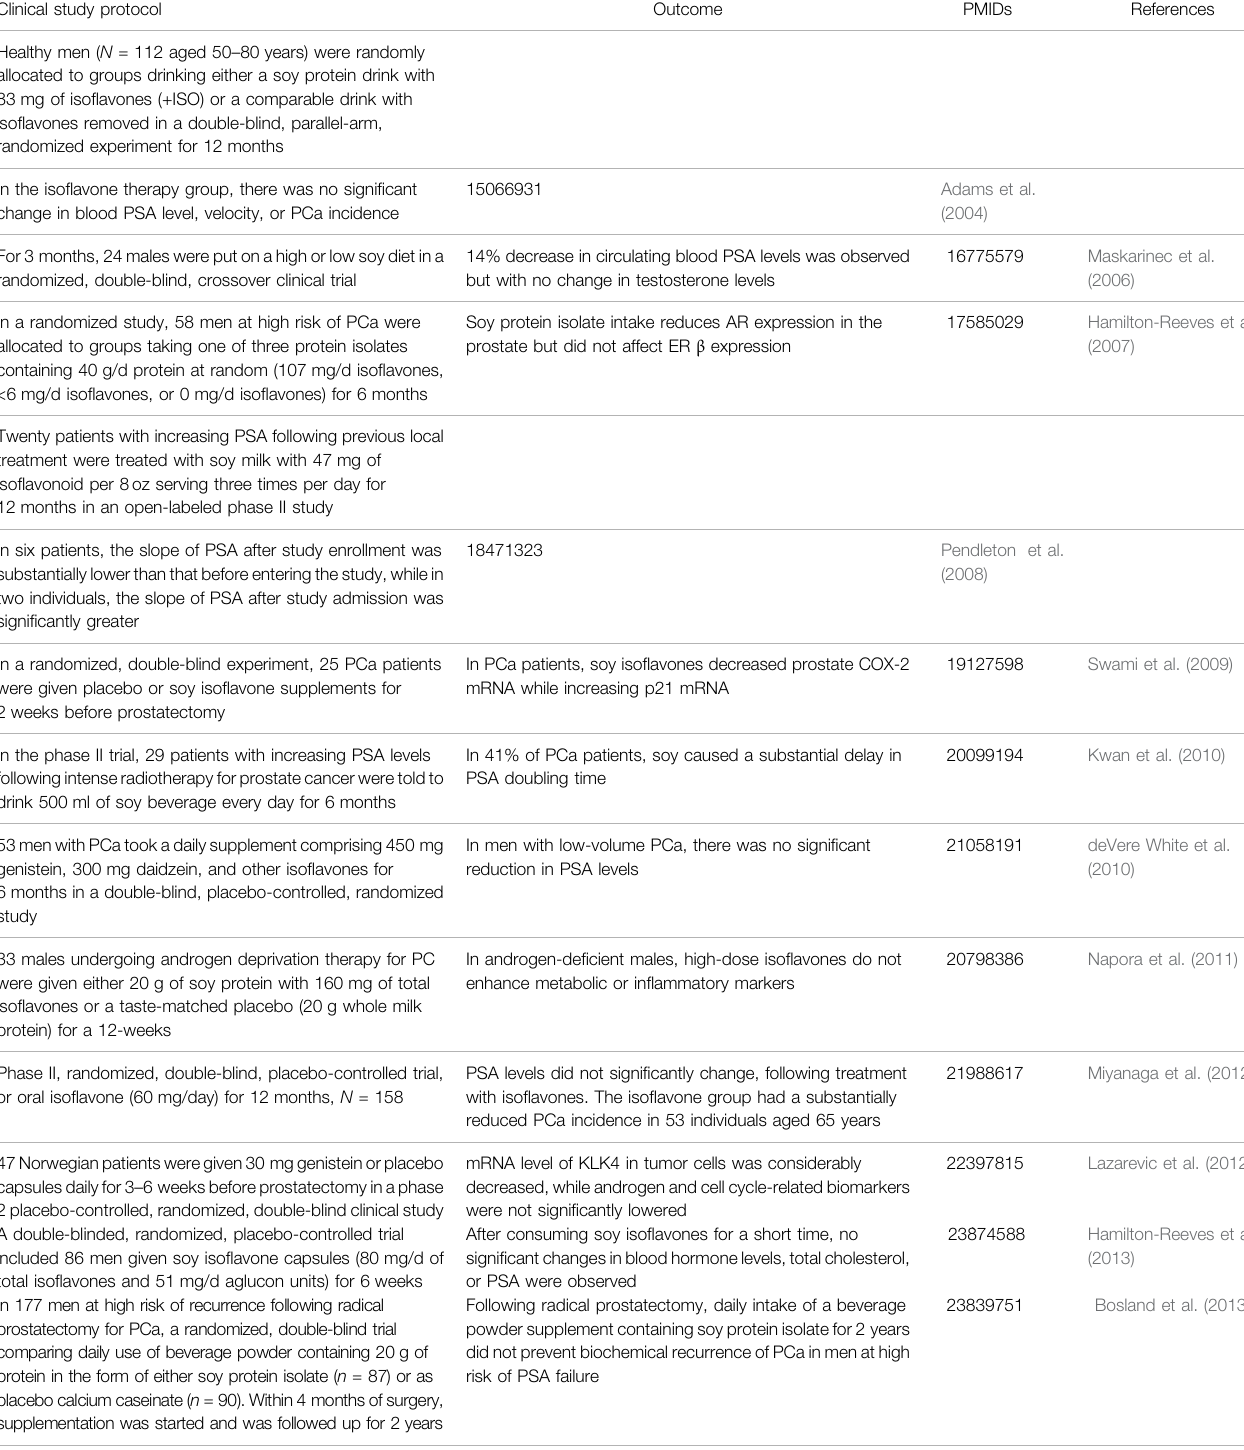
TABLE 1 | Clinical studies evaluating the potential of soy iso fl avones in reducing PSA